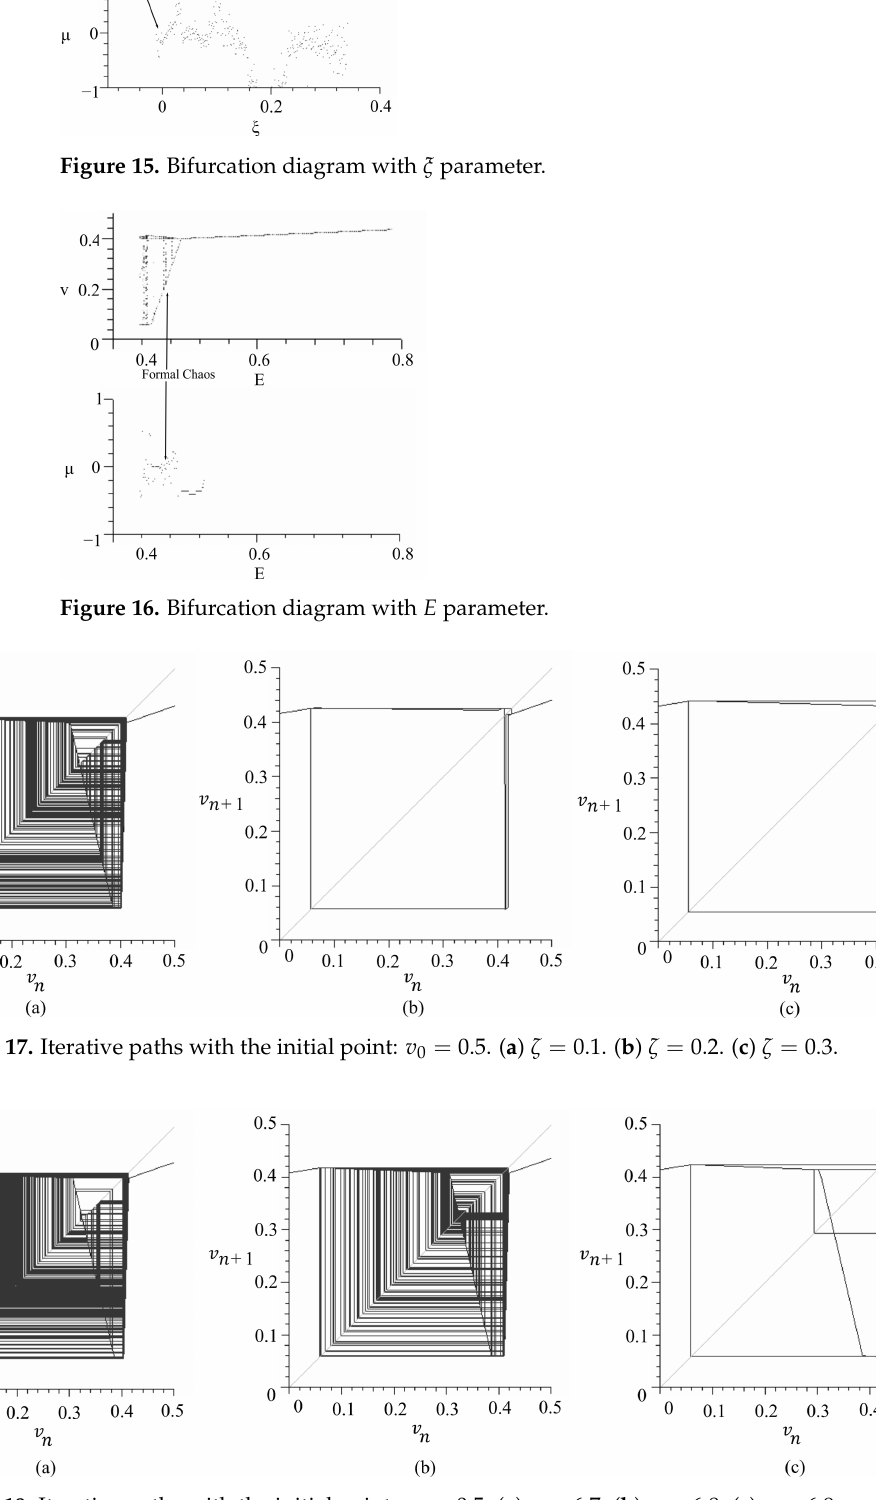
Figure 18. Iterative paths with the initial point: v 0 = 0.5. ( a ) η = 6.7. ( b ) η = 6.8. ( c ) η =